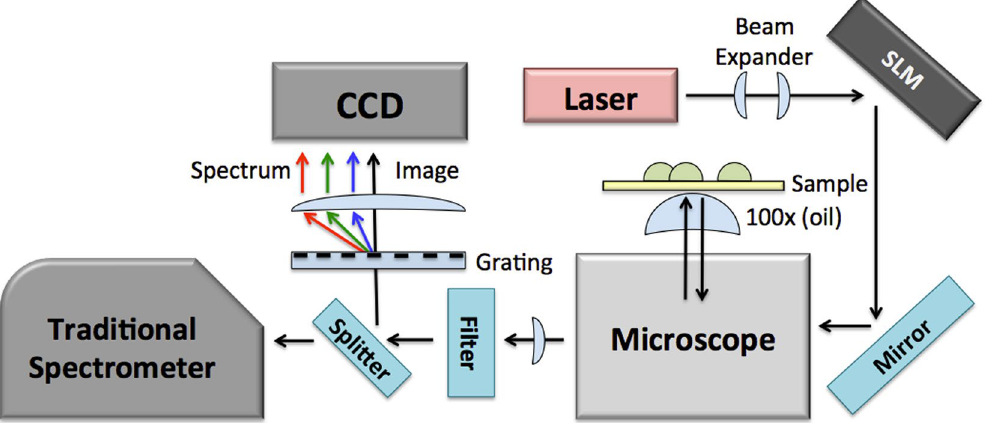
Figure 2. Schematic depicting the microscope and experimental setup. The light from a 660 nm laser reflects off of a spatial light modulator, allowing control and placement of the illuminating beam, and enters the inverted microscope. After interacting with the sample, the light exits the microscope and passed through a long-pass filter and a transmission grating, diffracting some of the light into a spectrum and passing the undiffracted light for imaging. The “Traditional Spectrometer” was used for traditional Raman spectral analysis and in the laser scanning Raman imaging experiments. The grating/CCD combination is a “hyper-spectral” imaging layout wherein a diffracted spectrum and a SERS-STORM image is recorded on the same video frame simultaneously on different halves of the CCD